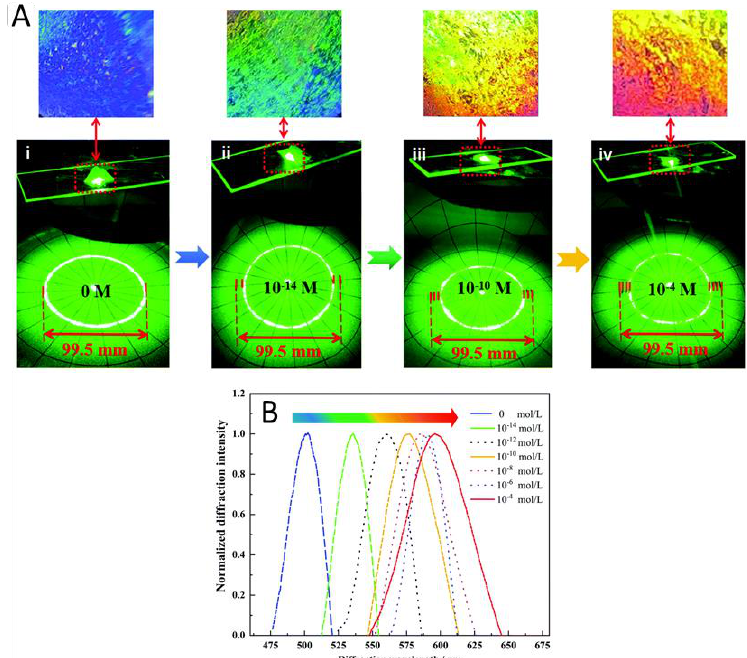
Figure 10. ( A ) Changes in the Debye ring diameter and colour of the SMZ–MIPCH sensor at different SMZ concentrations. ( B ) Dependence of the normalized diffraction spectra of SMZ–MIPCH on the SMZ concentration. (The measurement angle between the probe and the normal range to MIPCH is 21°). (Reprinted with permission from [114]. Copyright 2021 Royal Chemical Society). Two-dimensional PhCs can also be integrated with ternary complexes to improve the swelling of the hydrogel. Zhang et al. added tryptophan (Trp) and Zn 2+ to a PhC hydrogel